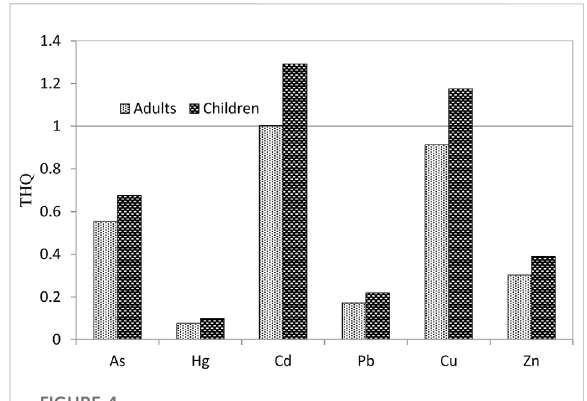
FIGURE 4 THQvaluesofmetalsthroughconsumptionofriceandmaize grown at the sampling sites of the study area (a histogram above the reference line may be subjected to potentially higher health